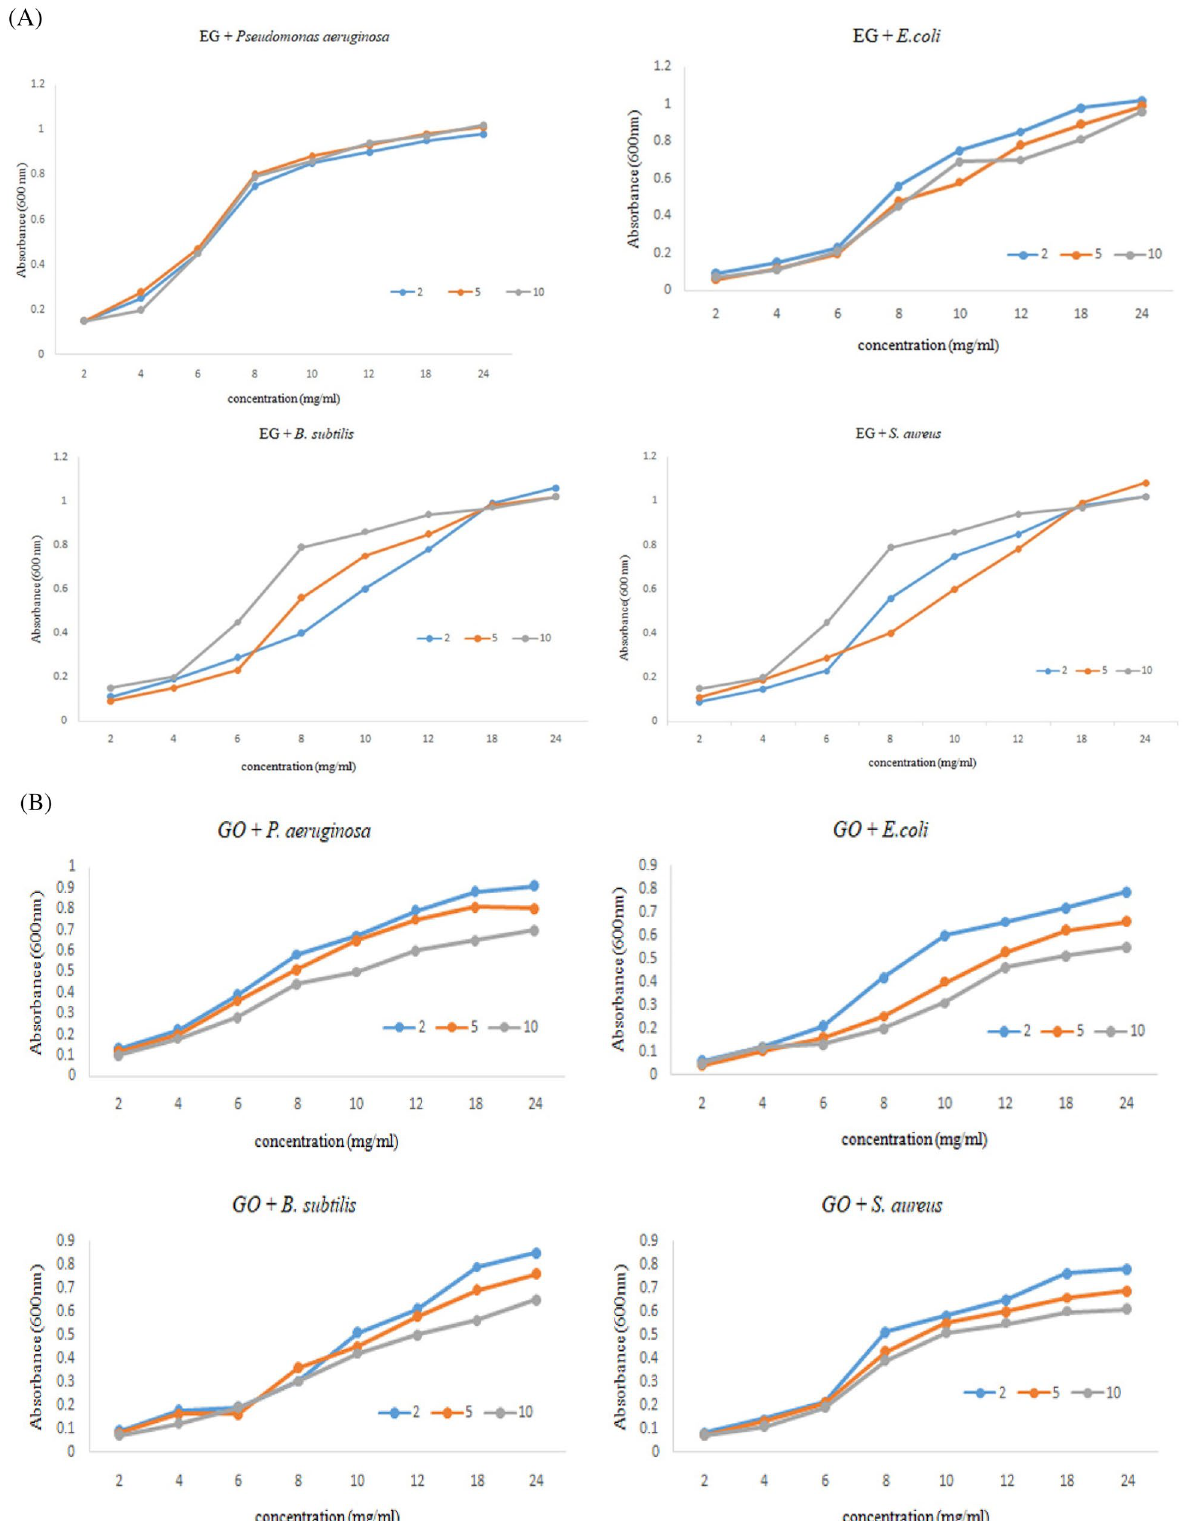
Figure 9. Microbial growth curve analysis. For EG: Growth curve of the P. aeruginosa , E.coli , B. subtilis and S. aureus exposed to the different concentrations ( A ). For GO: Growth curve of the P. aeruginosa , E. coli , B. subtilis and S. aureus exposed to GO with different concentrations ( B ). For SF@GOC (GO + M) : Growth curve of the P. aeruginosa , E. coli , B. subtilis and S. aureus exposed to SF@GOC with the different concentrations ( C